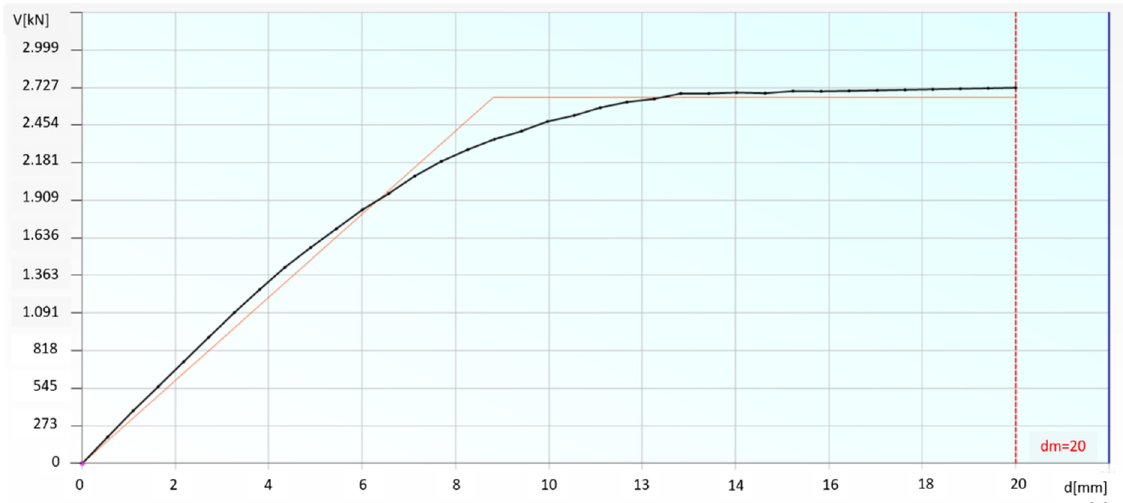
Figure 17. Capacity curve (black) and its bilinear idealization (orange) for y -direction. The pushover analysis was performed for all three distributions of lateral load with- out random eccentricity. Finally, the capacity/demand ratio obtained according to the simplified calculations and the values of the safety indices for critical analyses obtained using the 3Muri software were compared, as shown in Table 5. According to the regulation, the safety index is the ratio of peak ground acceleration for which the structure reaches a certain limit state, i.e., capacity and peak ground acceleration (PGA), i.e., demand. PGA for a return period of 95 years was used, and it has a value of 0.13 g. The limit state of significant damage (SD) was observed.